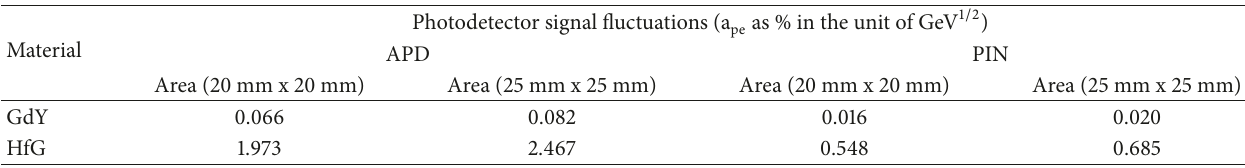
Table 2: The photostatistics parts of the parameterized energy resolution function (a pe ) with different scintillator back face areas and photodetector